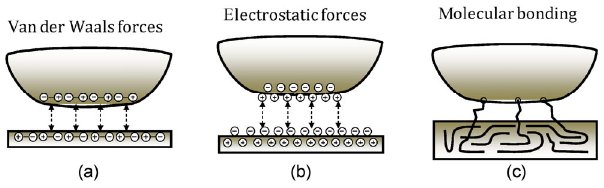
Fig. 1 General types of an adhesion interaction in the polymer interface (adopted from Ref.